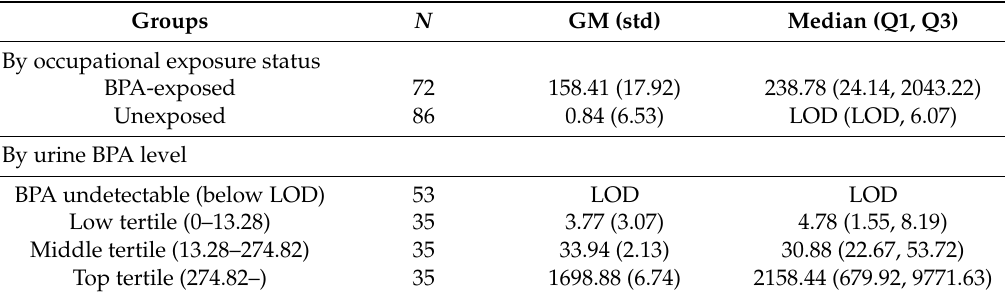
Table 2. Urine BPA levels ( µ g/g creatinine) between groups.